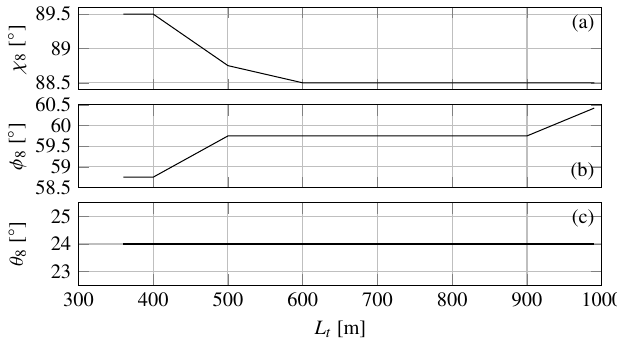
Figure 10. Kite flight trajectory parameter versus tether length. ( a ) Trajectory angle χ 8 ; ( b ) Azimuth of the center of the trajectory; ( c ) elevation of the center of the trajectory.